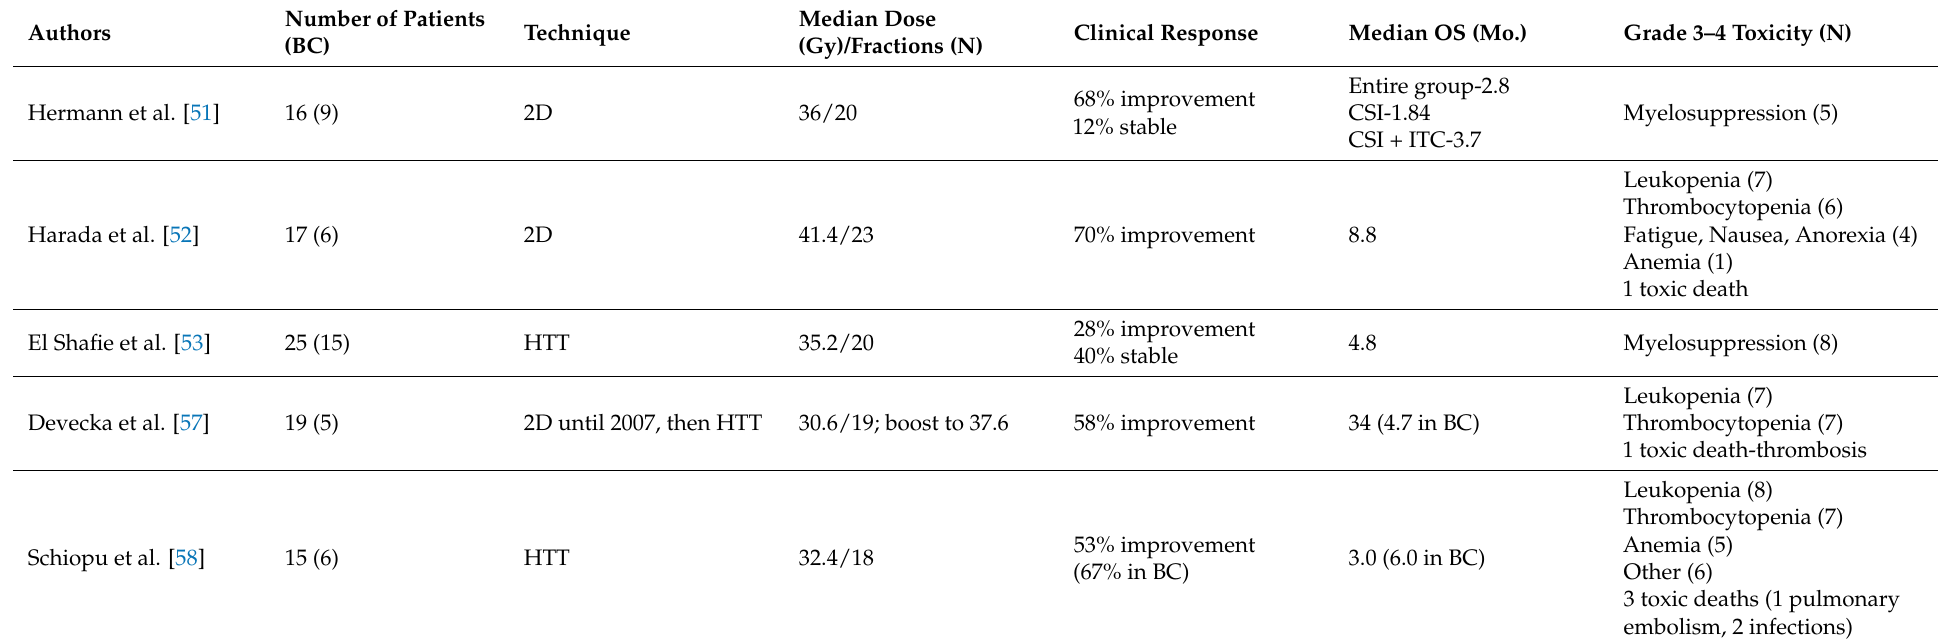
Table 3. Clinical trials evaluating the role of craniospinal irradiation for leptomeningeal carcinomatosis in breast